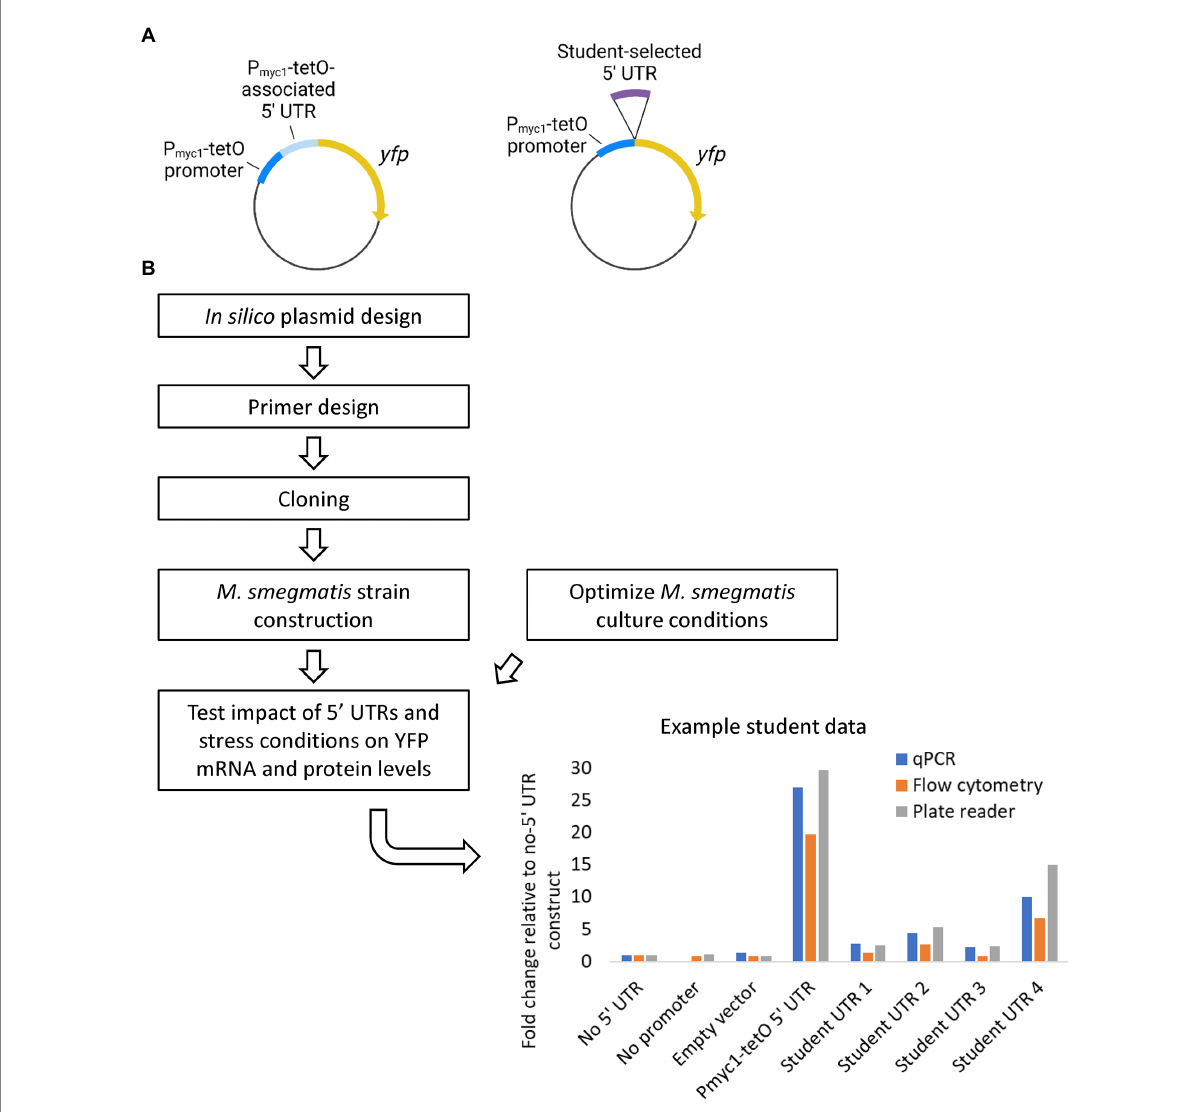
FIGURE 4 Research thrust 1: Using reporters to evaluate 5 ′ UTR roles. (A) Plasmids used to assess the effects of 5 ′ UTRs on expression of the reporter gene yfp . The